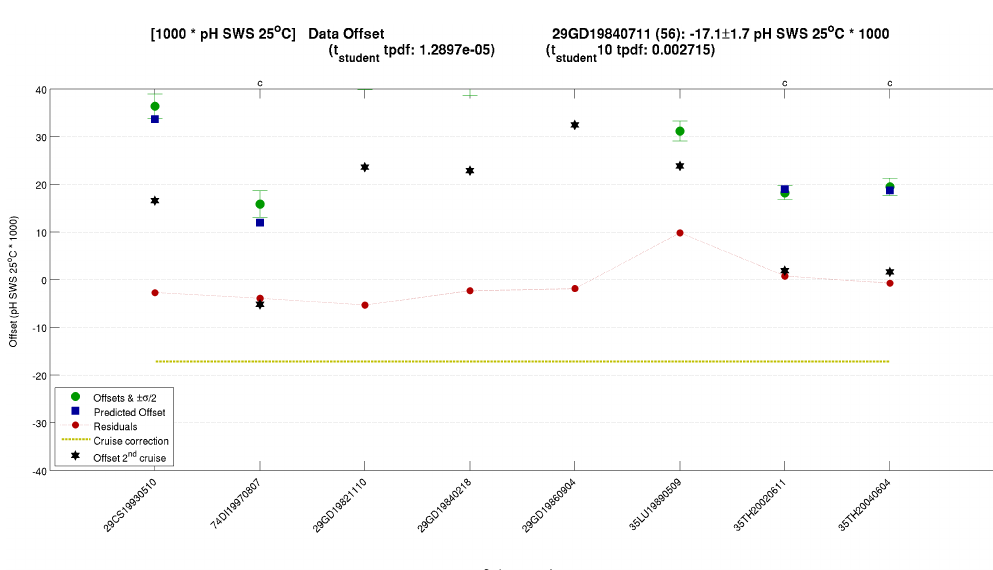
Figure 11. Cruise crossover information plot for 29GD19840711 (56).